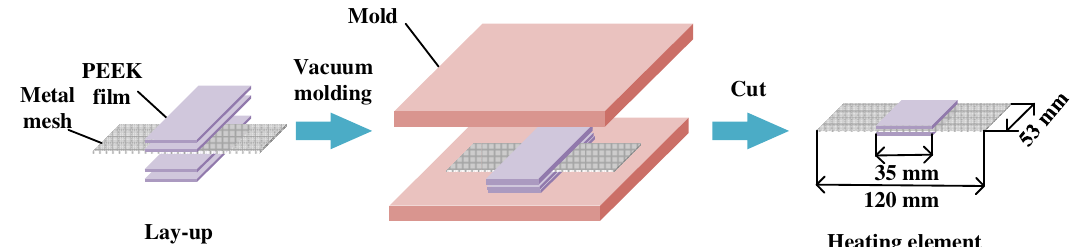
Figure 2. Schematic of preparation method for heating